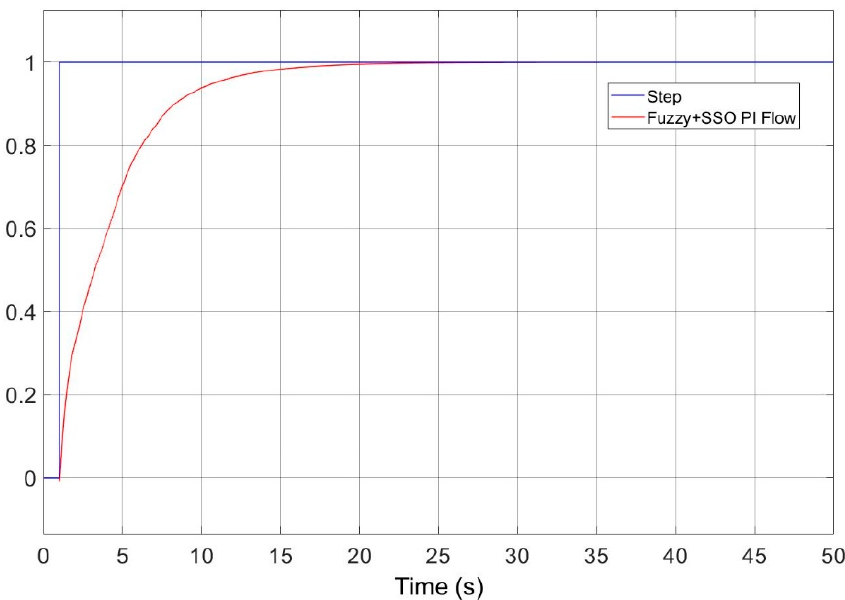
Figure 21. Temperature versus time plot for PID tuned with SSO and SSO fuzzy.